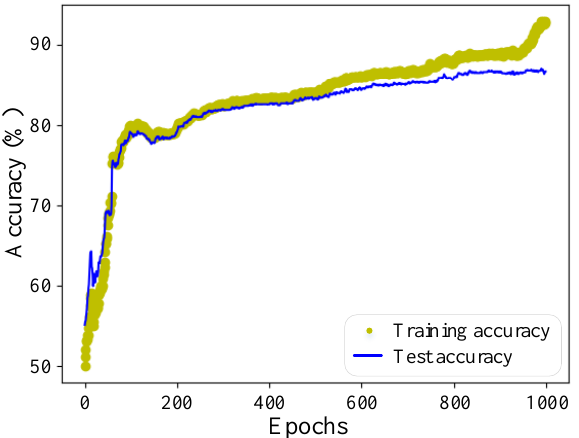
Figure 9. FLS model accuracy using two-step training strategy.